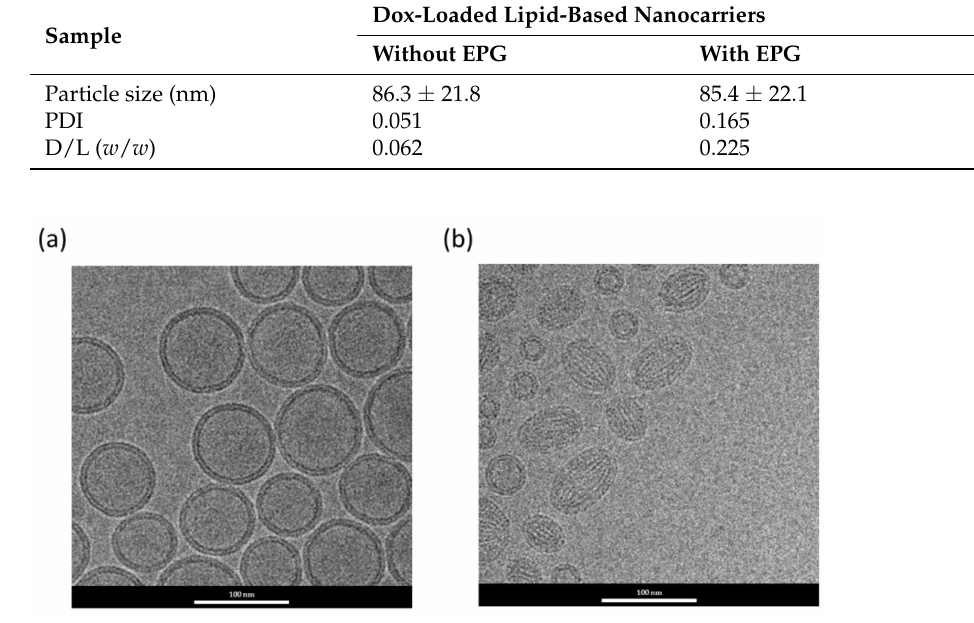
Figure 2. Cryo-TEM micrograph of Dox-loaded lipid-based nanocarriers prepared without ( a ) or with ( b )